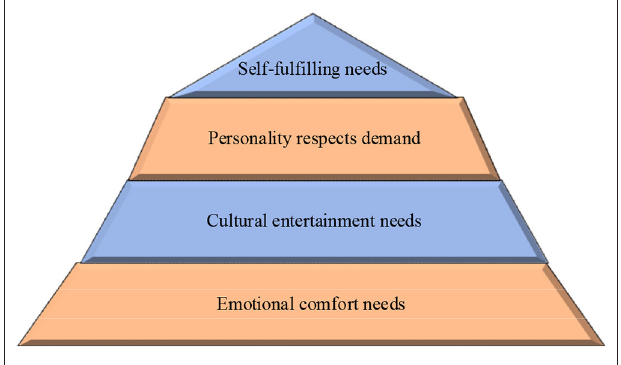
FIGURE 3 | The spiritual needs of the elderly.